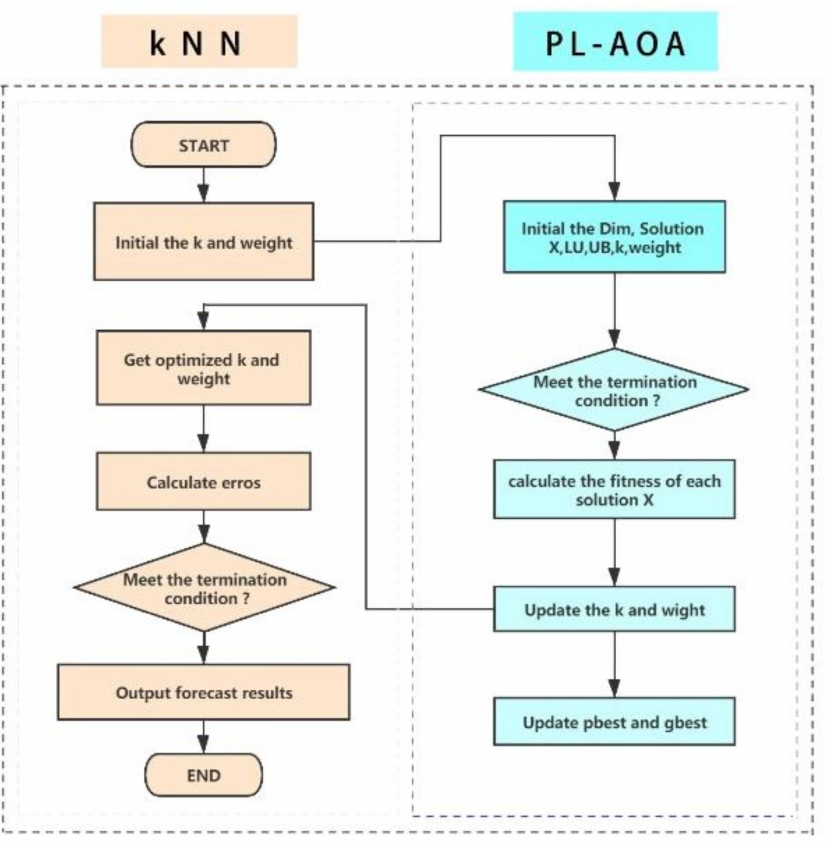
Figure 2. PL-AOA combined with